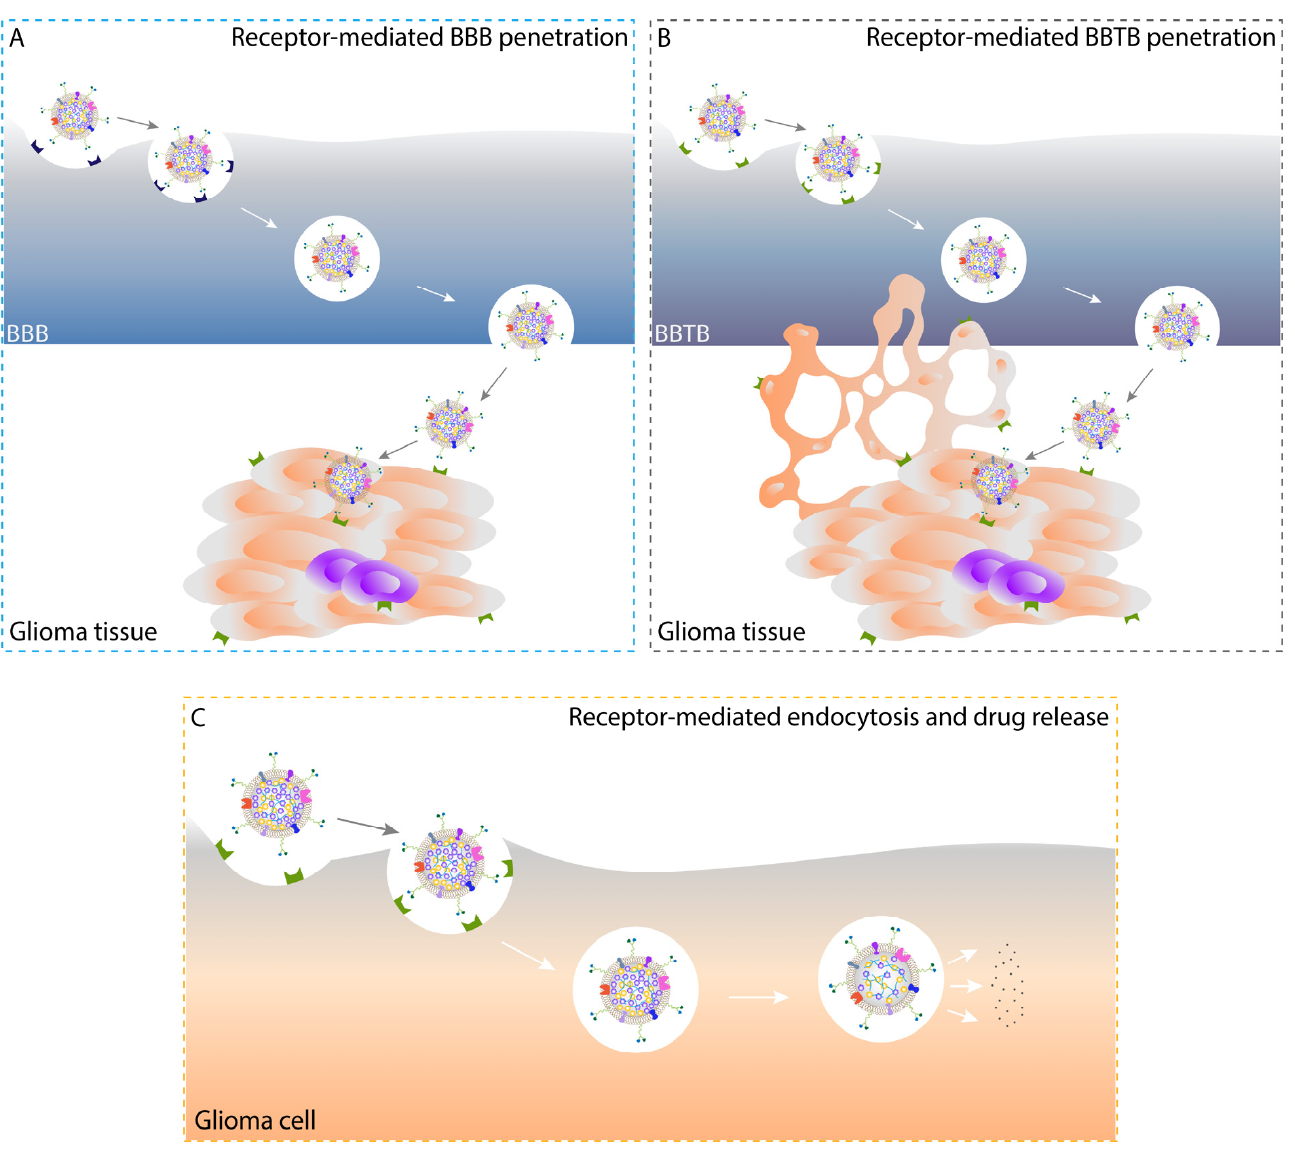
Figure 2. Schematic illustration of receptor-mediated BBB ( A ) and BBTB ( B ) penetration, and receptor-mediated endocytosis and subsequent intracellular drug release ( C ) enabled by active tumor-targeted drug NCs in vivo. BBB, blood-brain barrier; BBTB, blood-brain tumor barrier; NCs, nanocrystals.